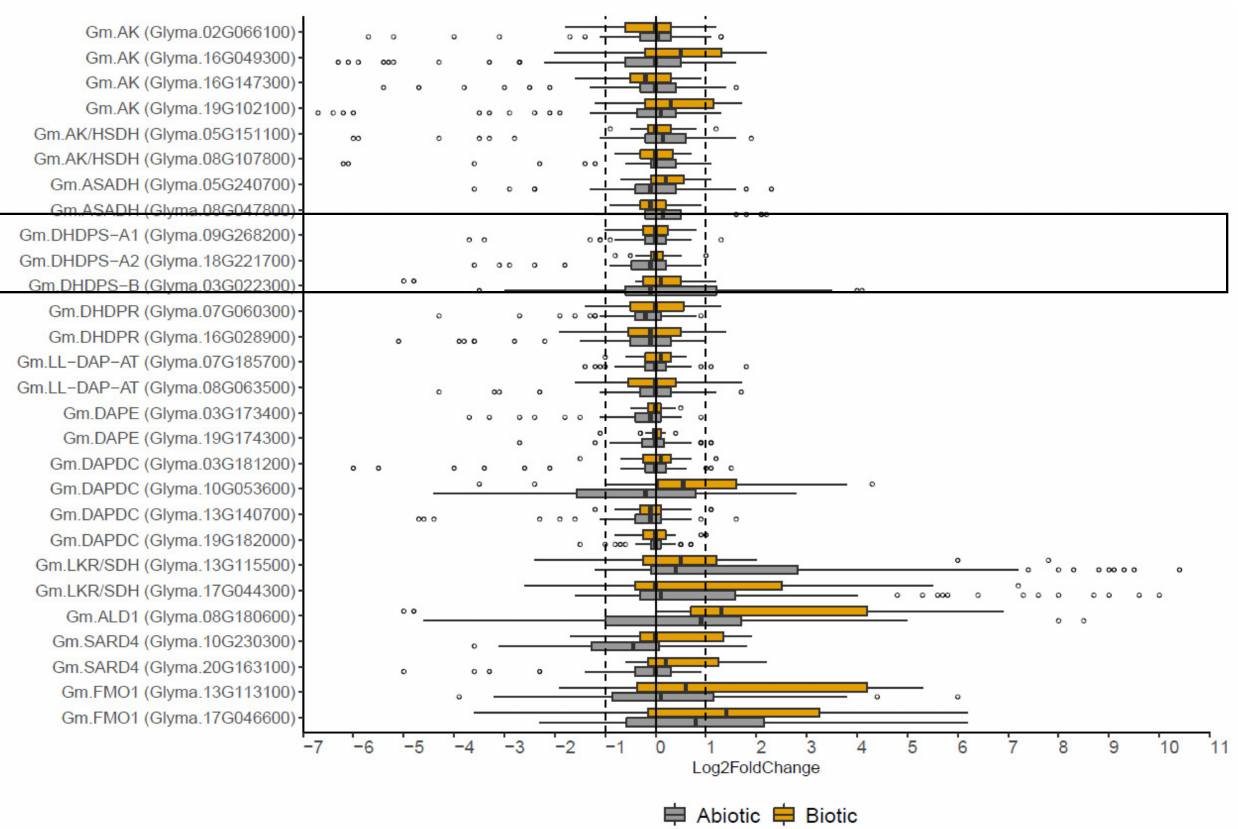
Figure 6. Boxplots for differential expression values (Log2Fold changes, X -axis) of genes ( Y -axis) involved in lysine biosynthesis ( AK, AK/HSDH, ASADH, DHDPS (boxed) , DHDPR, LL-DAP-AT, DAPE, DAPDC ), lysine catabolism ( LKD/SDH ) and SAR response ( ALD1, SARD4, FMO1 ) by re- analysis of 23 biotic and 70 abiotic stress RNA-seq experiments in